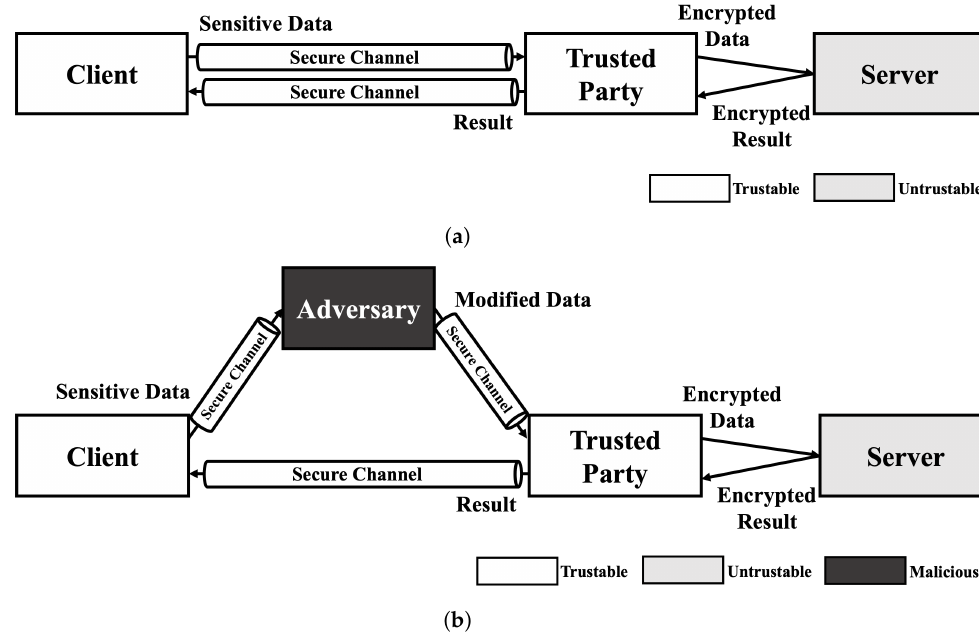
Figure 1. Service scenario of HE deep learning model and exploit scenario using adversarial example. ( a ) Normal scenario of HE-based deep learning model service. ( b ) Adversarial attack scenario using Man-In-The-Middle (MITM)